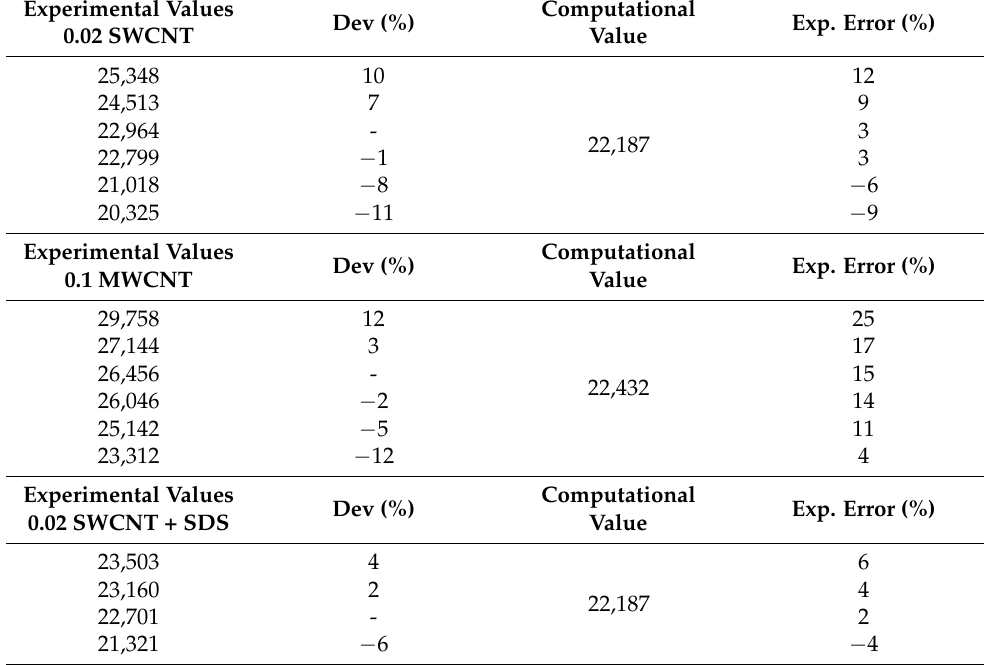
Table 5. Experimental Young’s modulus values (MPa) obtained with (4) for each specimen and mean value (calculated, not measured), deviation percentage with respect to the mean value, computational model Young’s modulus (MPa), and experimental error for each